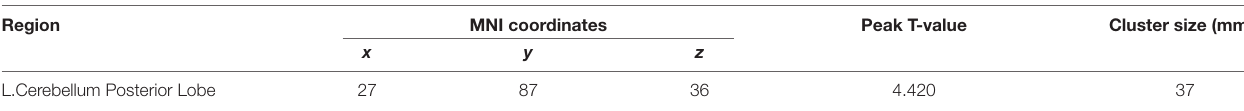
TABLE 3 | Brain regions with significant amplitude of low frequency fluctuation (ALFF) differences between VM patients before and after VR.